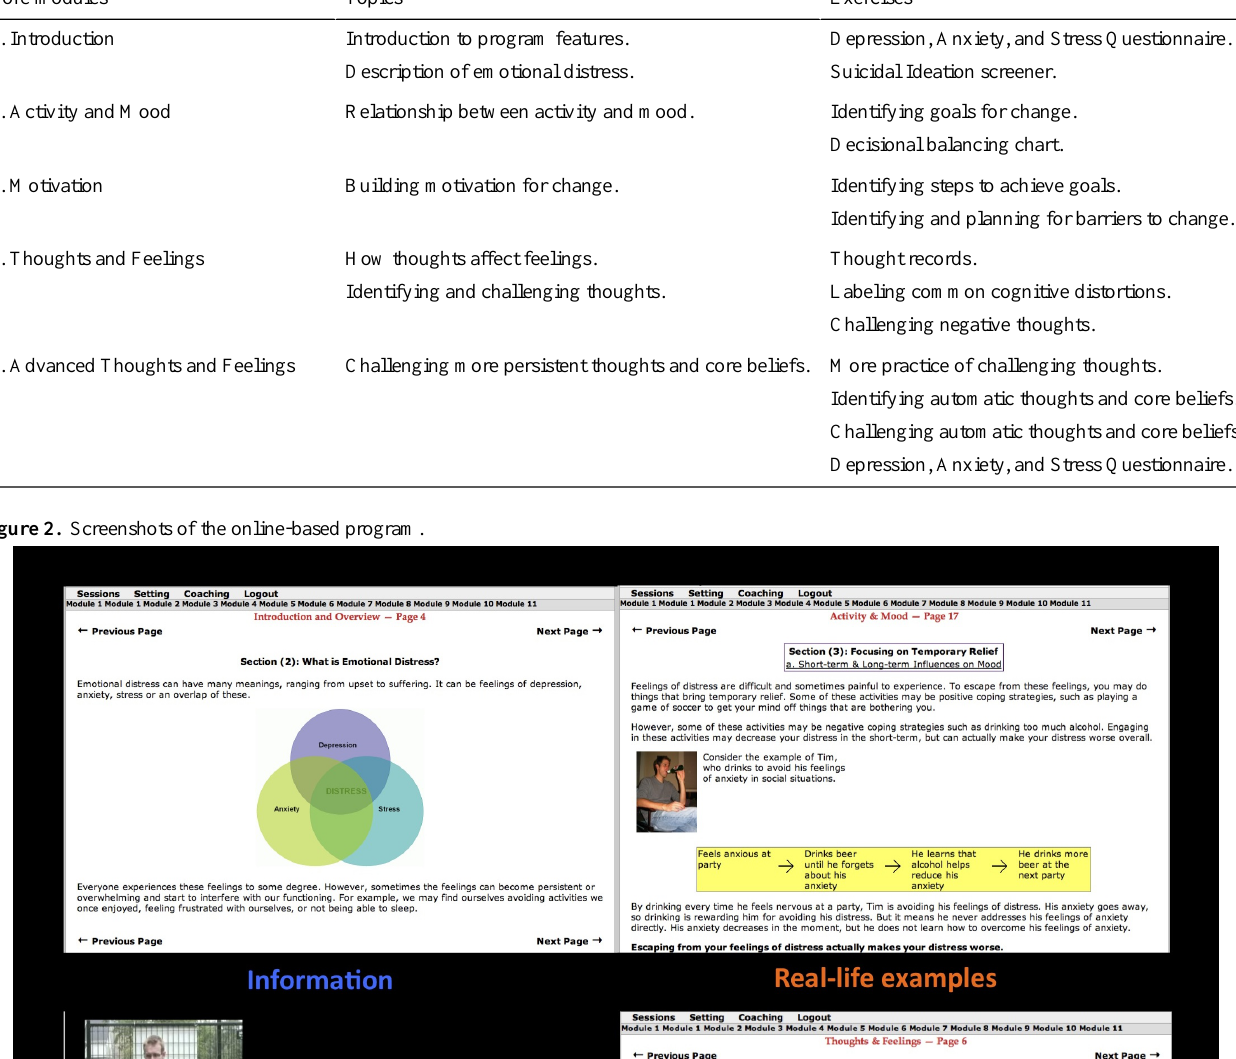
Table 1. Description of core modules. ExercisesTopicsCore modules